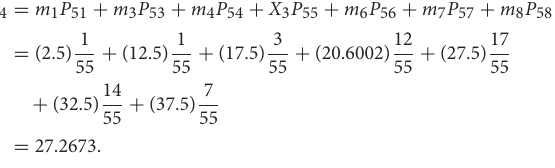
transformation data at t = 4 are as